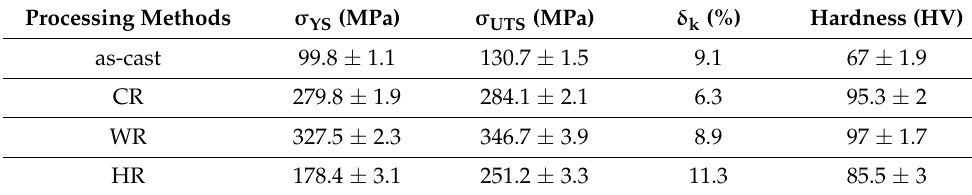
Figure 6. Fracture morphology of WE43 magnesium alloy under tension at room temperature in different states: ( a ) as-cast, ( b ) cold-rolled, ( c ) warm-rolled, and ( d ) hot-rolled.